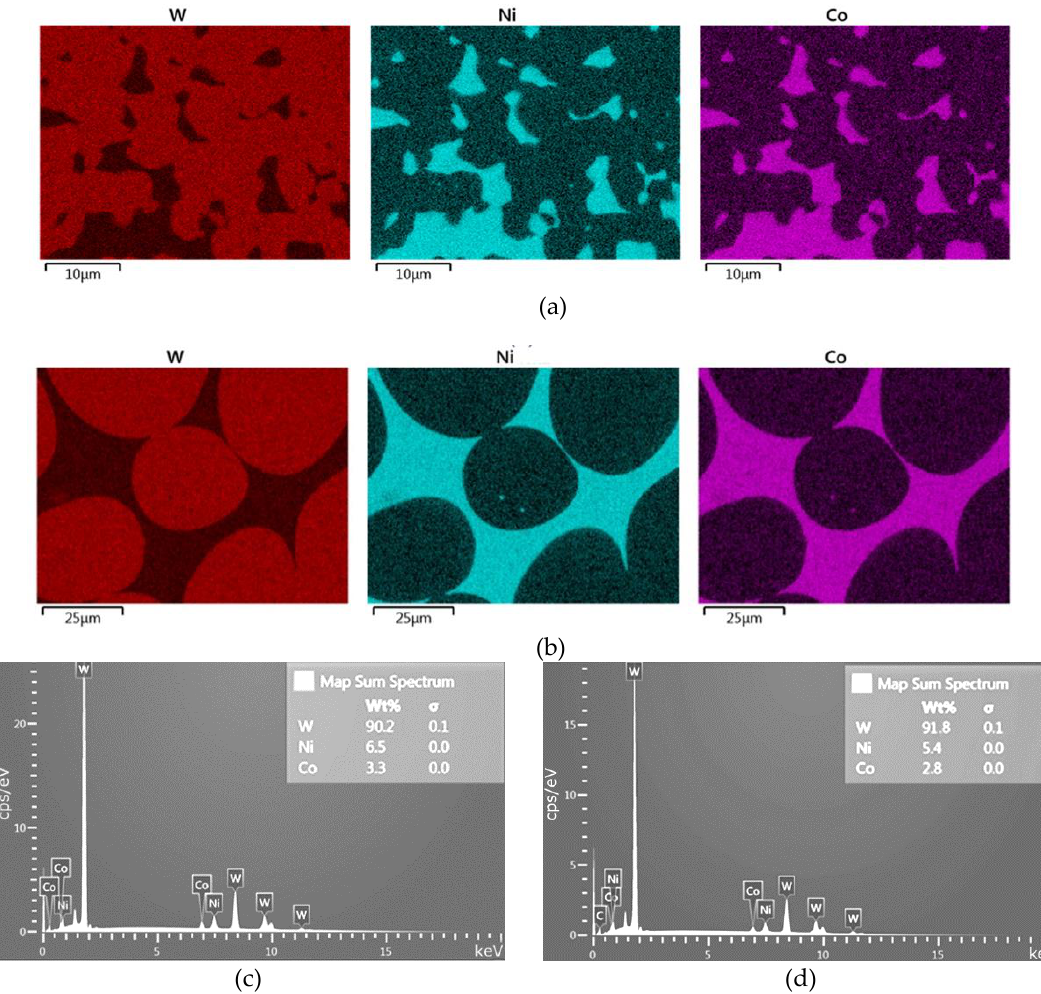
Figure 3. SEM-EDX maps of distribution of individual elements (W-red, Ni-blue, Co-violet) for sintered pieces: 1500 °C/30 min ( a ); 1525 °C/30 min ( b ); quantitative evaluation of individual elements within maps depicted in ( a ) and ( b ) in investigated structures, in wt. %: 1500 °C/30 min ( c ); 1525 °C/30 min ( d ).